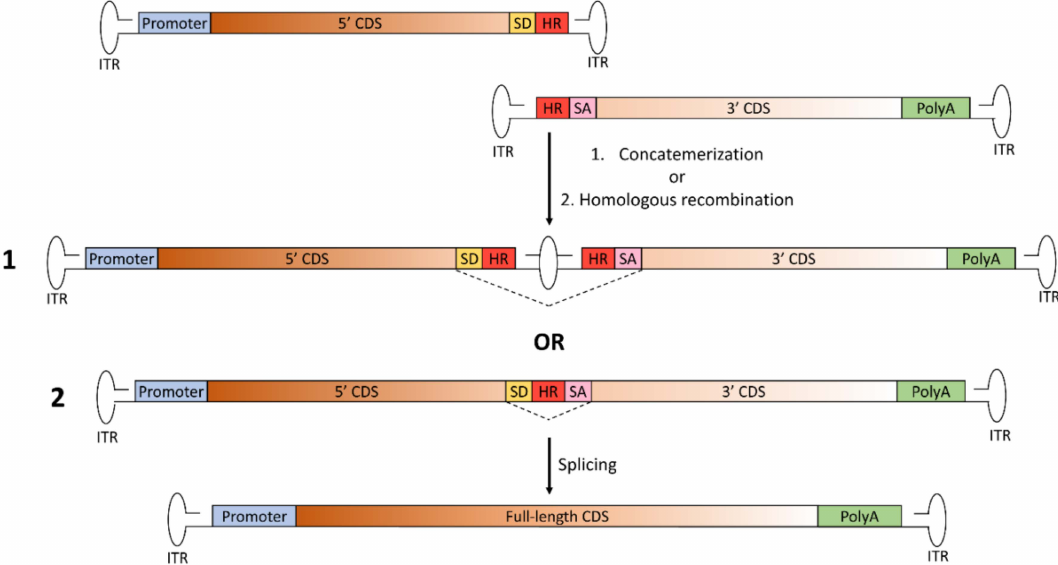
Figure 3. Schematic representation of the hybrid dual AAV approach for large gene reconstitution. The first vector includes the promoter, the 5’-half of the coding sequence (CDS), the splicing donor (SD) signal and the highly recombinogenic exogenous sequence (HR); the second vector includes the highly recombinogenic exogenous sequence, the splicing acceptor (SA) signal, the 3’-half of the CDS and the polyadenylation signal (PolyA). Joining of the two AAV vector genomes to reconstitute the full-length gene can occur through either: 1. concatemerization of the two vectors through the inverted terminal repeats (ITR), as for trans-splicing dual AAV vectors; or 2. homologous recombination mediated by the region of homology included in both vectors. In both cases, after transcription, splicing leads to the removal of the junction point, with restoration of the full-length, mature RNA of the